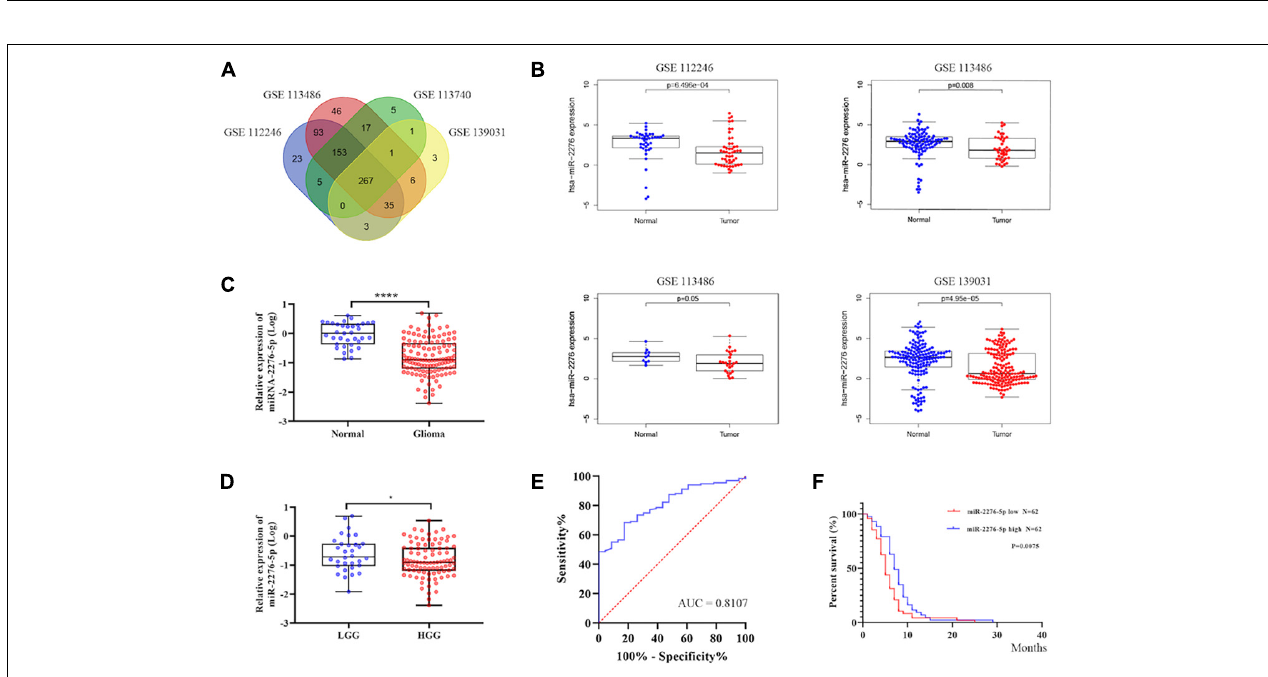
FIGURE 2 | Exosomal miR-2276-5p could be a potential diagnostic and prognostic biomarker in glioma. (A,B) The relative expression of miR-2276-5p in glioma patients’ plasma in GSE139031, GSE113740, GSE113486, and GSE112246. (C) The relative expression of miR-2276-5p in glioma patients’ plasma exosomes. (D) The relative expression of miR-2276-5p in LGG and HGG patients’ plasma exosomes. (E) The receiver operating characteristics analysis curve of the miR-2276-5p and the AUC was 0.8107. (F) Correlation of expression level of exosomal miR-2276-5p with the overall survival rate of glioma patients. * p < 0.05, **** p < 0.0001.